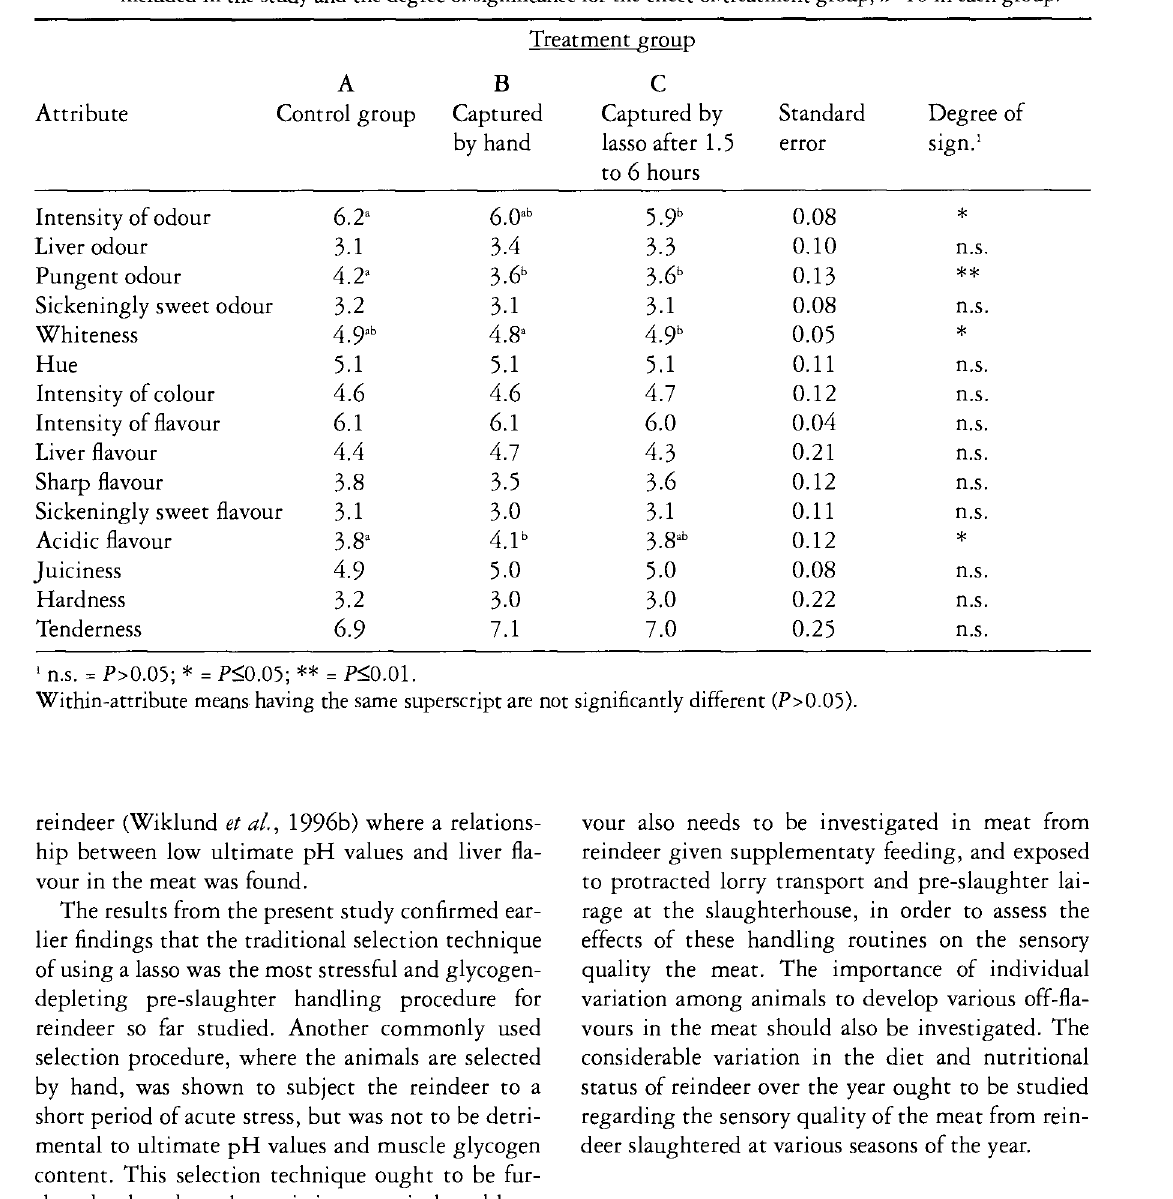
Table 5. Sensory evaluation scores in meat (M. longissimus) (least-squares means and standard errors) from reindeer bulls included in the study and the degree of significance for the effect of treatment group, n= 10 in each